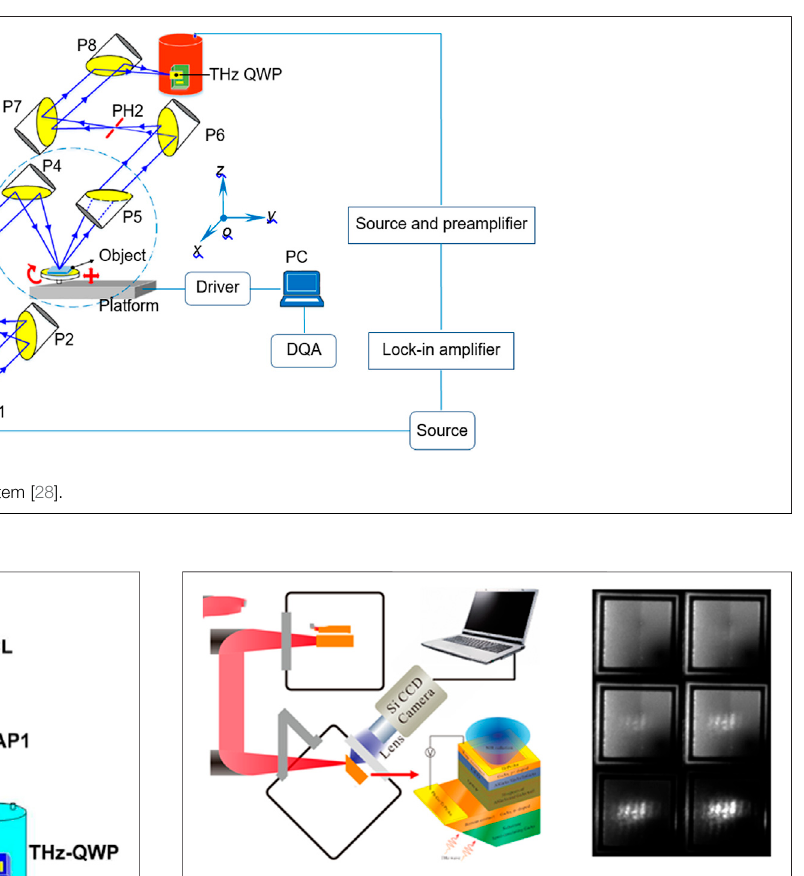
FIGURE 6 | (A) Set-up for THz pixel-less imaging system; (B) The focal laser spots of THz QCL imaged by using THz QWP-LED